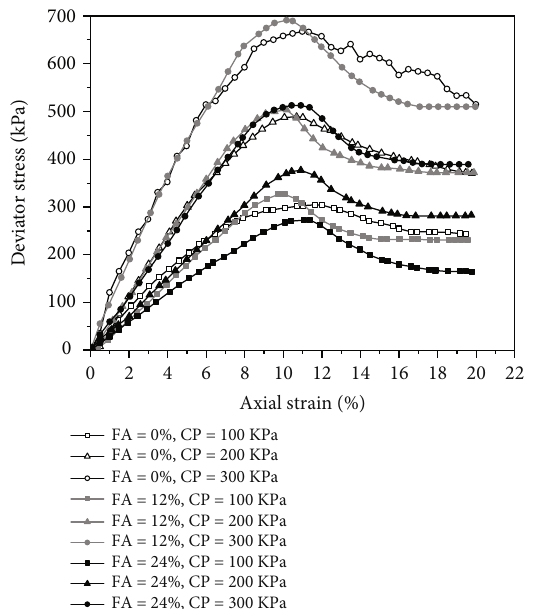
Figure 13: Stress-strain curves ( FT = 60 , L = 0 % ).